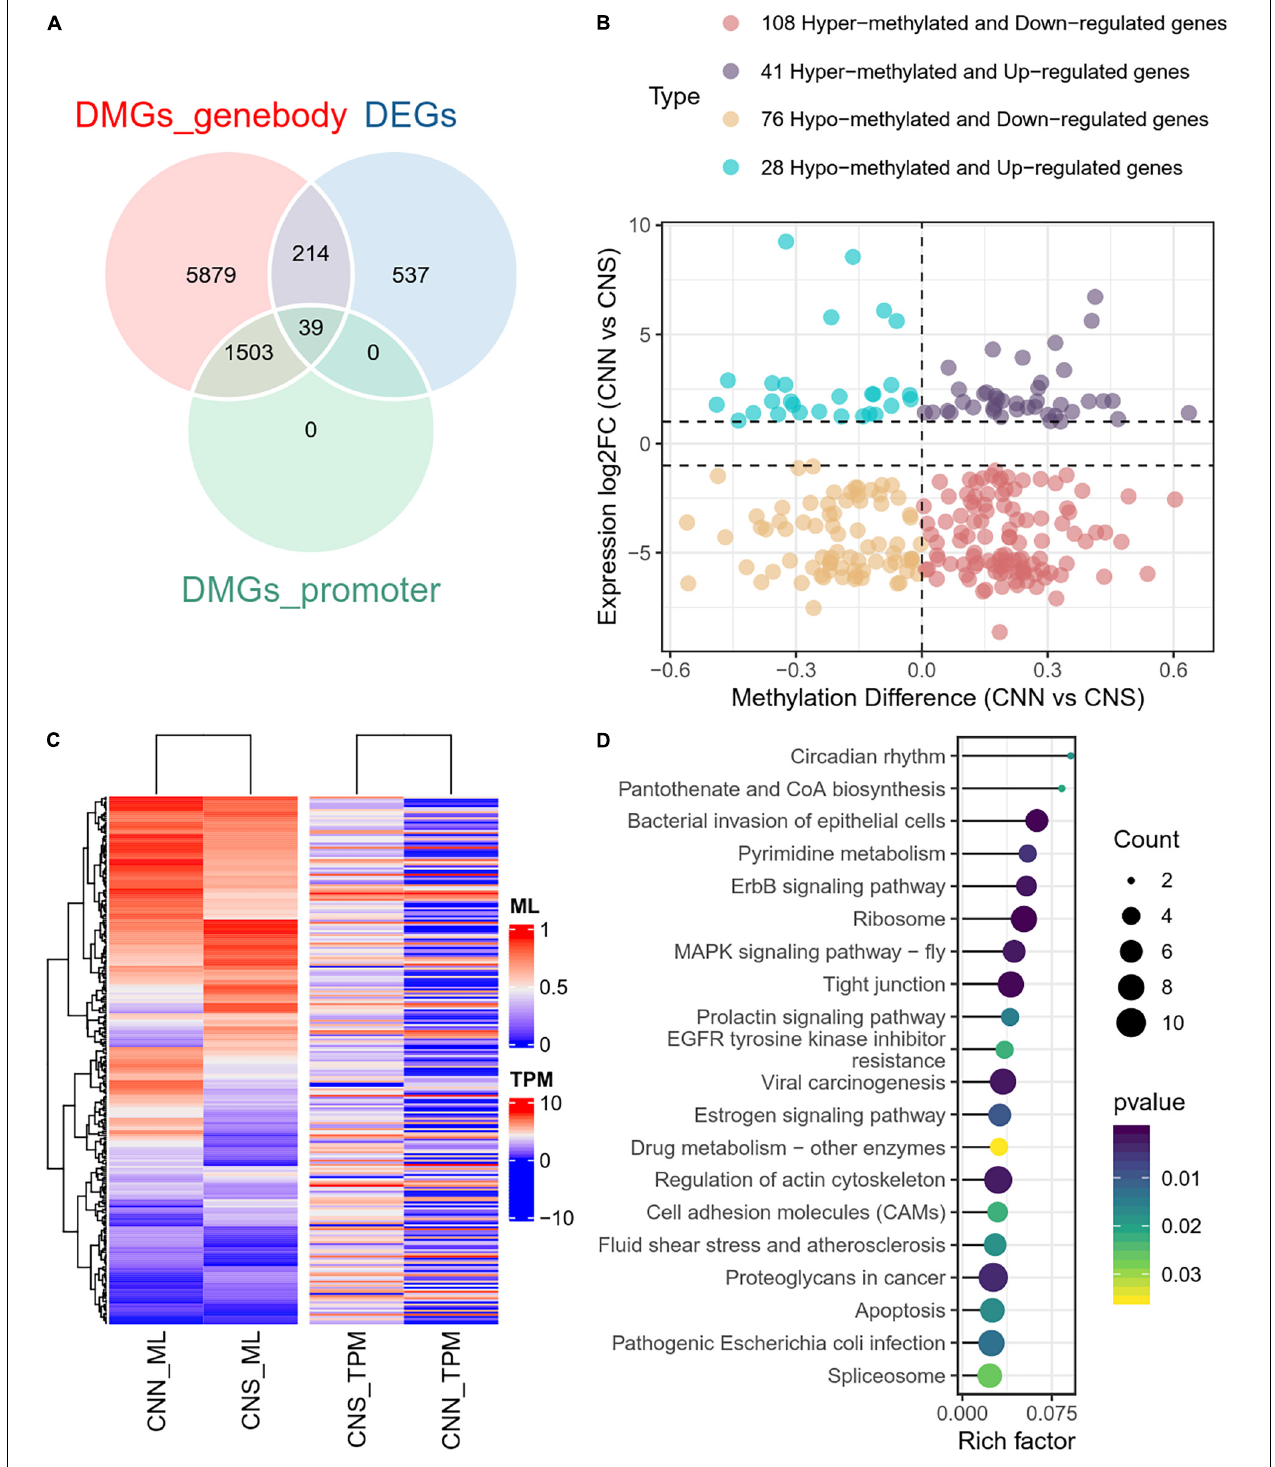
FIGURE 5 | (A) Venn plot of overlapped genes of DMGs and DEGs between CNN and CNS populations. (B) Scatter plot showing the correlation between the expression log2 fold change and methylation difference in the 253 overlapped genes of DMGs and DEGs between CNN and CNS populations across the H. discus hannai chromosome-scaled genome. (C) Heatmap showing the methylation levels (ML) and expression profiles (TPM) of the 253 overlapped genes in CNN and CNS populations. (D) Scatter plot showing the top 20 enriched KEGG pathways derived from KEGG enrichment analysis of the 253 overlapped genes.